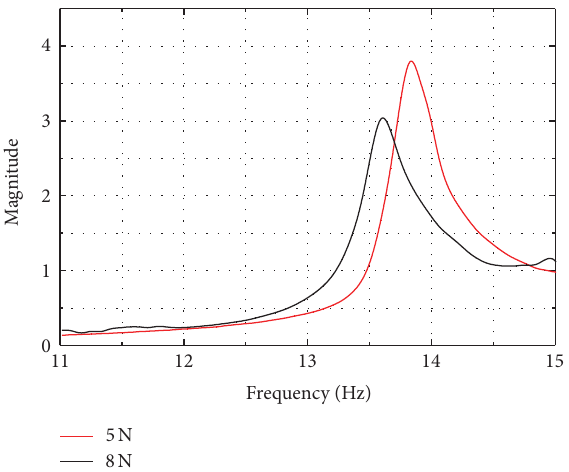
Figure 9: Variation of Young’s modulus with the design cycles.